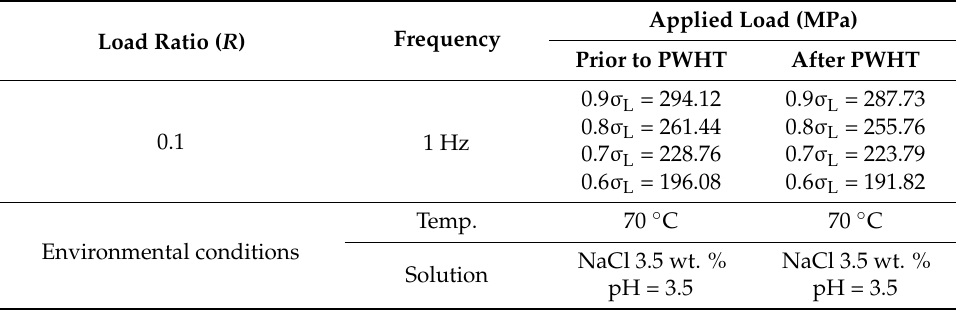
Table 7. Conditions of corrosion fatigue test.